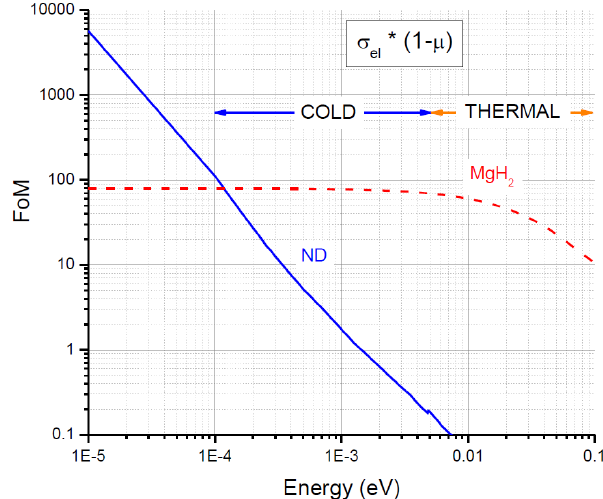
Fig. 10 : Comparison of the indicated figure of merit for nanodiamond and MgH neutron energy